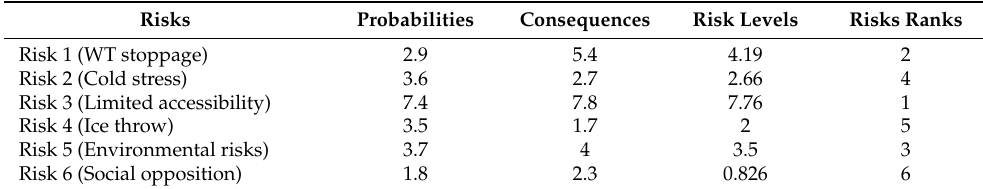
Table 7. Ranking of risks considering average values of probabilities, consequences, and risk levels.